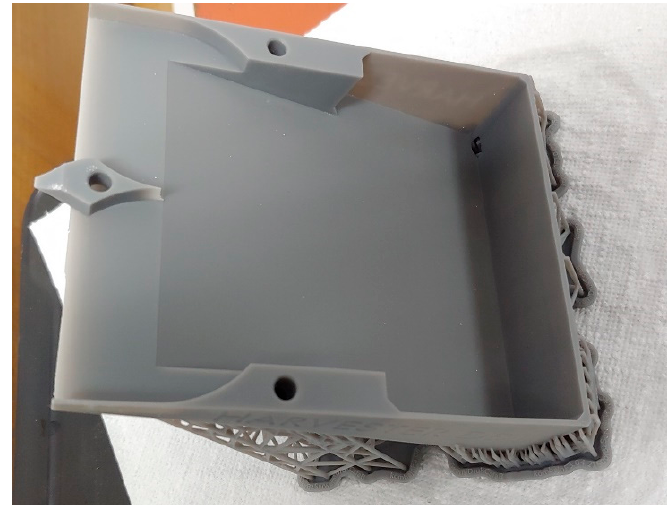
Figure 7. Harvester main body produced using the SLA method. The rotating blades of the machine were made using the FDM technique for both bodies. The blade and the entire assembled machine are shown in Figure 8.